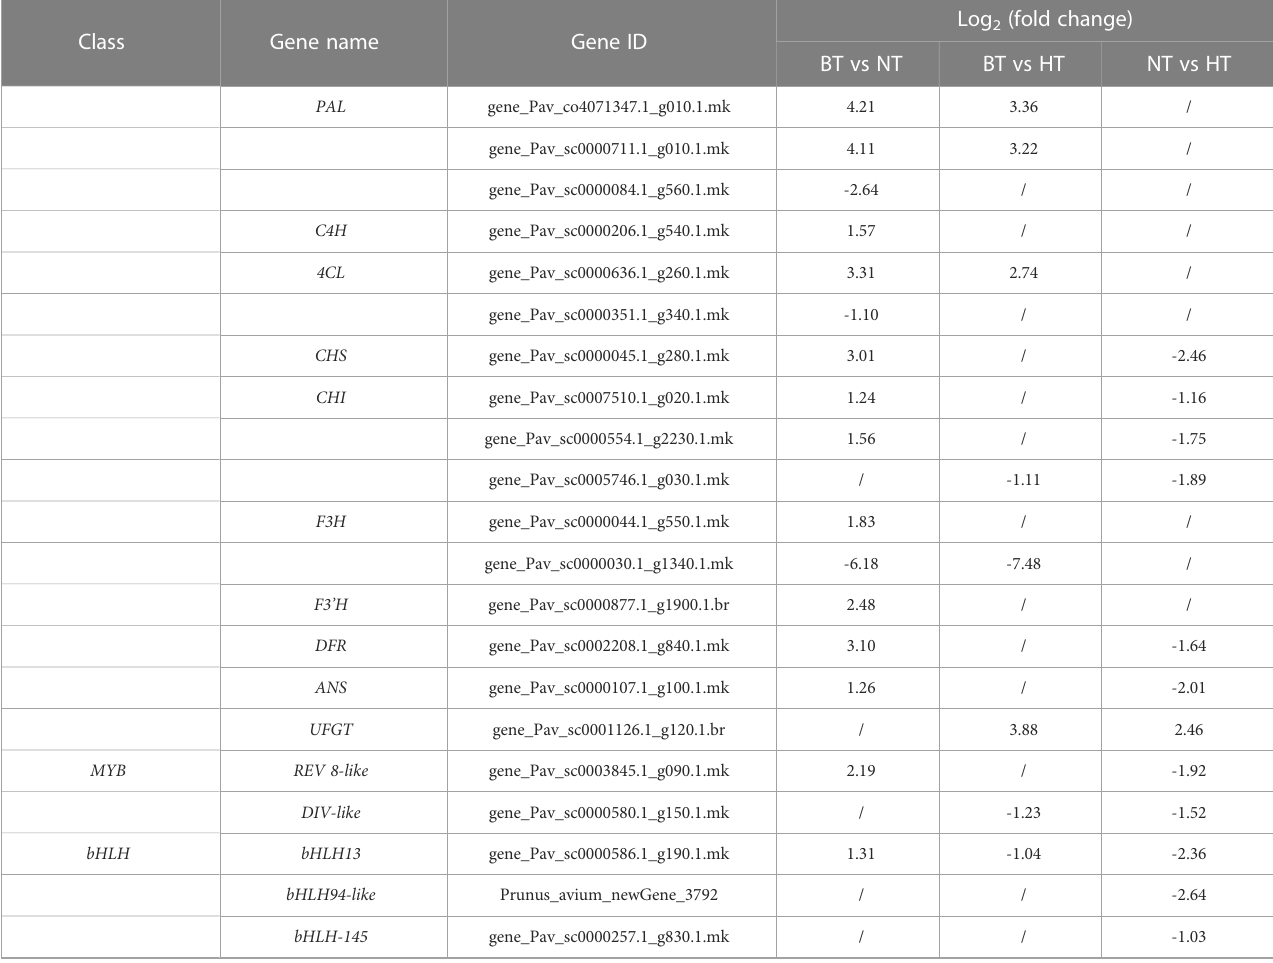
TABLE 1 Differentially expressed structural genes involved in anthocyanin biosynthesis and downregulated MYB , bHLH and WD40 genes in NT vs. HT.